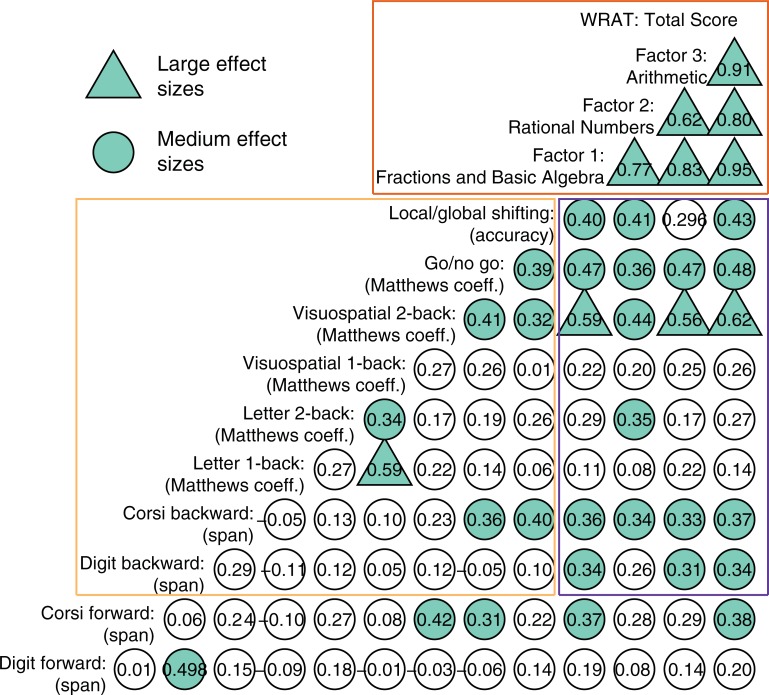
Pearson correlation coefficients between the executive function tasks (yellow rectangle), between the factors of the math computation subtest (orange rectangle), and between the executive function tasks and math factors (blue rectangle).Correlations with values > .3 have p < .05; correlations with values > .4 have p < .01; correlation with values > .5 have p < .001.